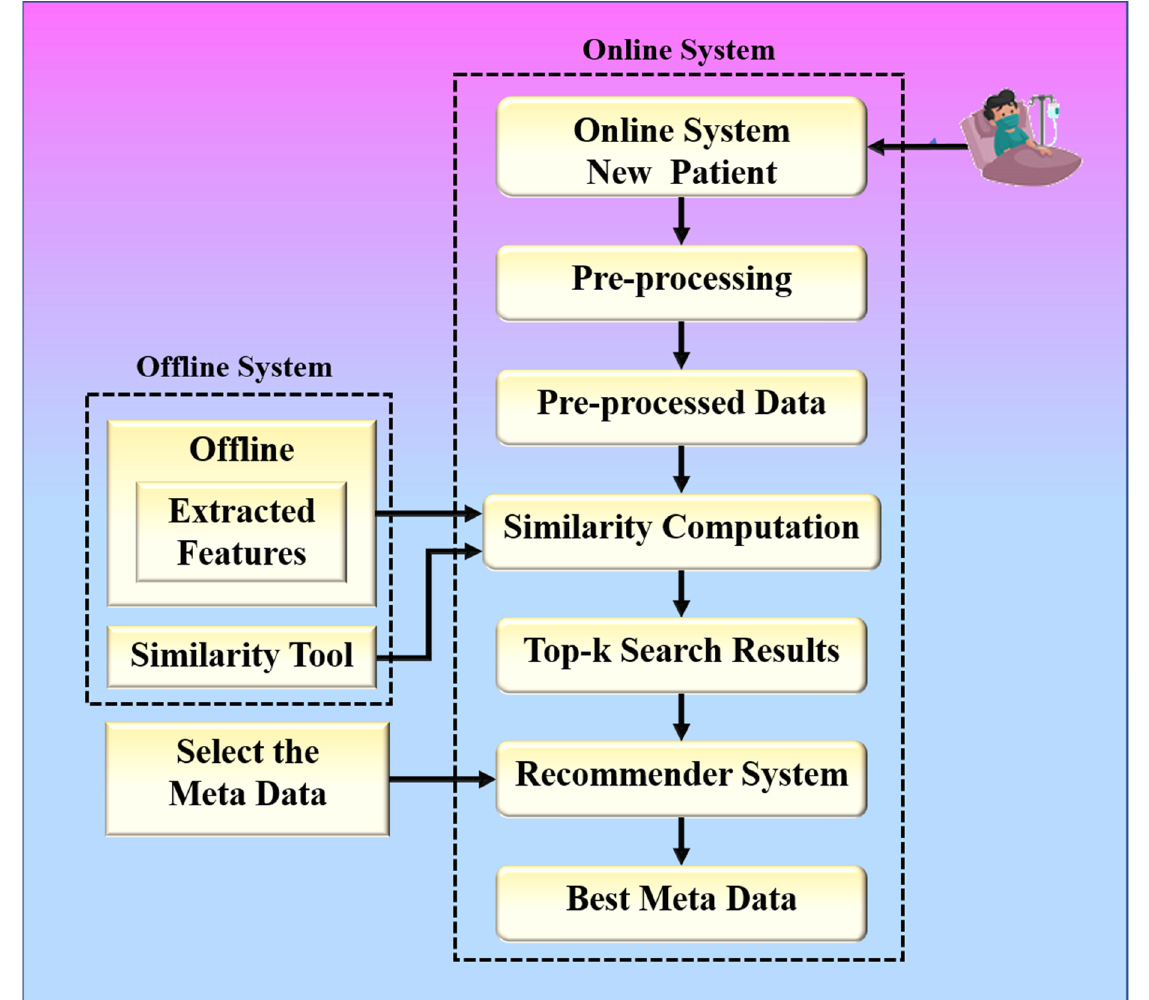
Figure 2. The global treatment recommender system for COVID-19.